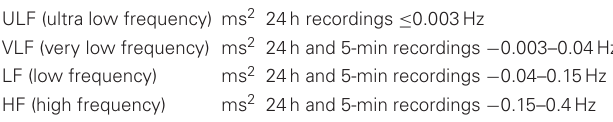
Table 2 | HRV metrics in frequency